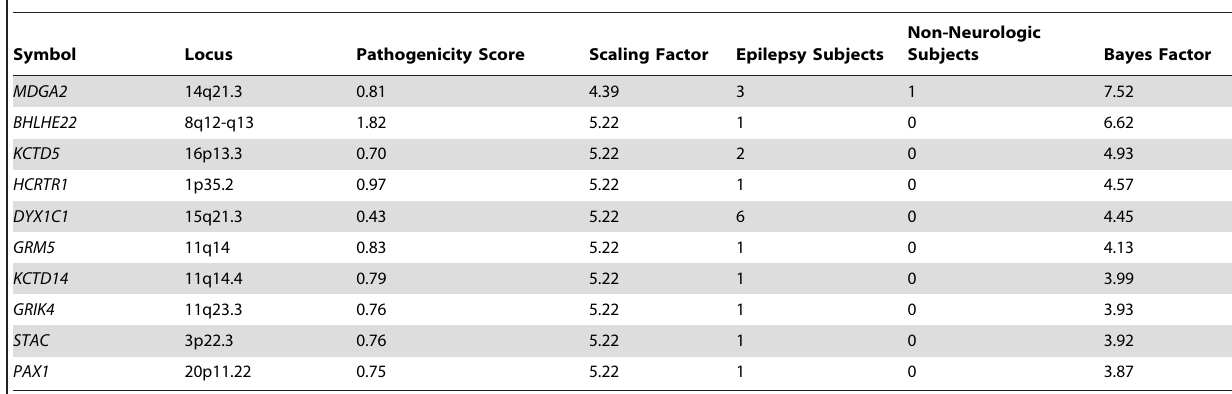
Table 3. Bayes factors of interesting novel candidate genes in epilepsy.